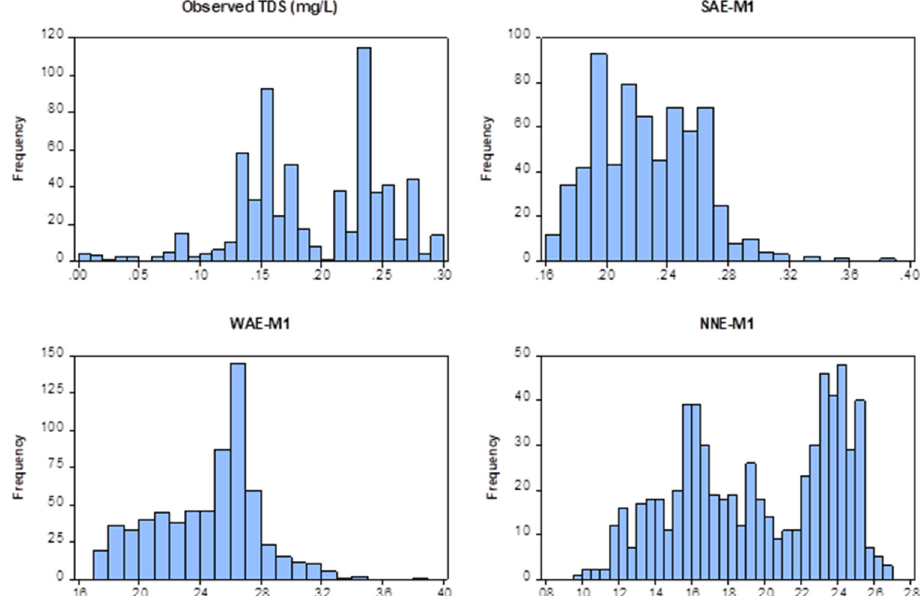
Figure 12. Frequency bar plots (SAE-M1, WAE-M1, and NNE-M1) for TDS.